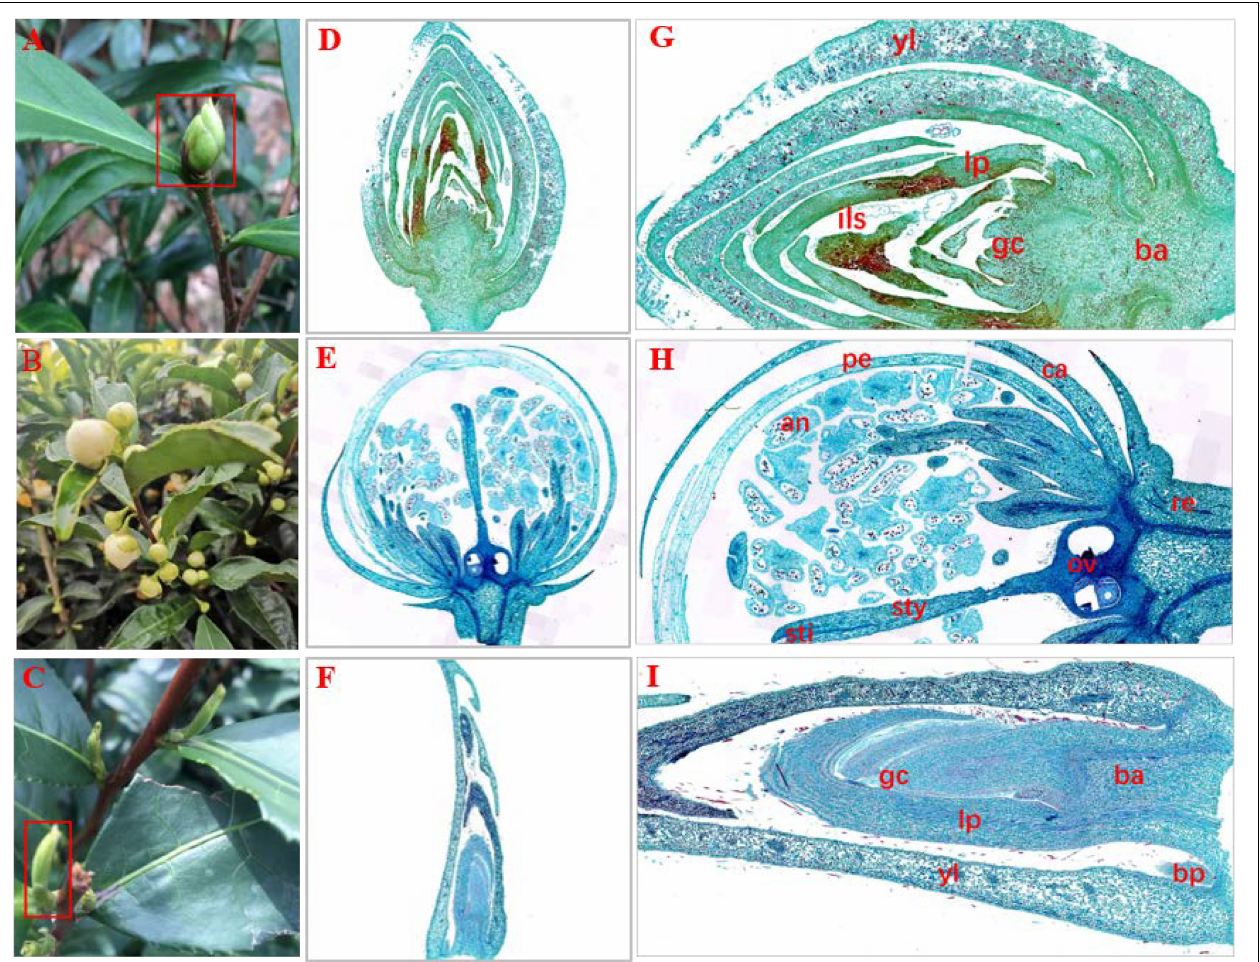
FIGURE 1 | Morphology and histology of flower buds (HB), dormant buds (DB) and an unknown tissue (SB) of tea plants. (A–C) Morphology of (A) SB, (B) FB, and (C) DB. (D–I) Longitudinal sections of different tissues of SB (D,G) , FB (E,H) , and DB (F,I) . (G) ils, insect-like structure. (H) pe, petal; an, anther; sti, stigma; sty, style; ov, ovary; ca, calyx; re, receptacle. (I) gc, growth cone; yl, young leaves; lp, leaf primordium; bp, bud primordium; ba, bud axis.